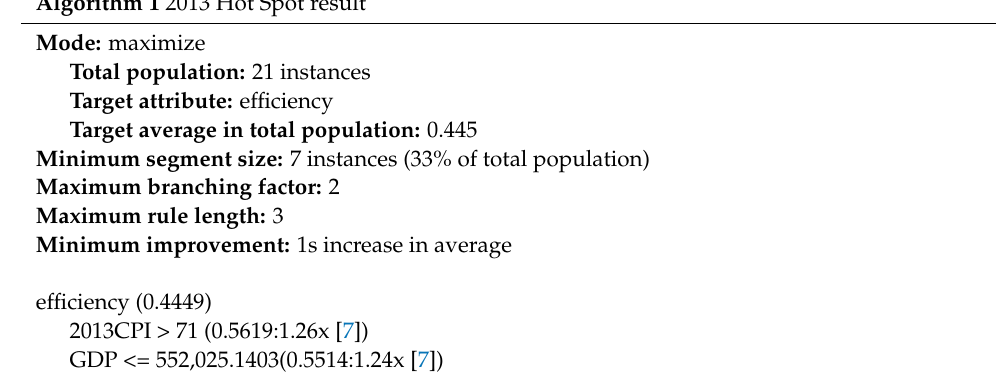
Algorithm 1 2013 Hot Spot